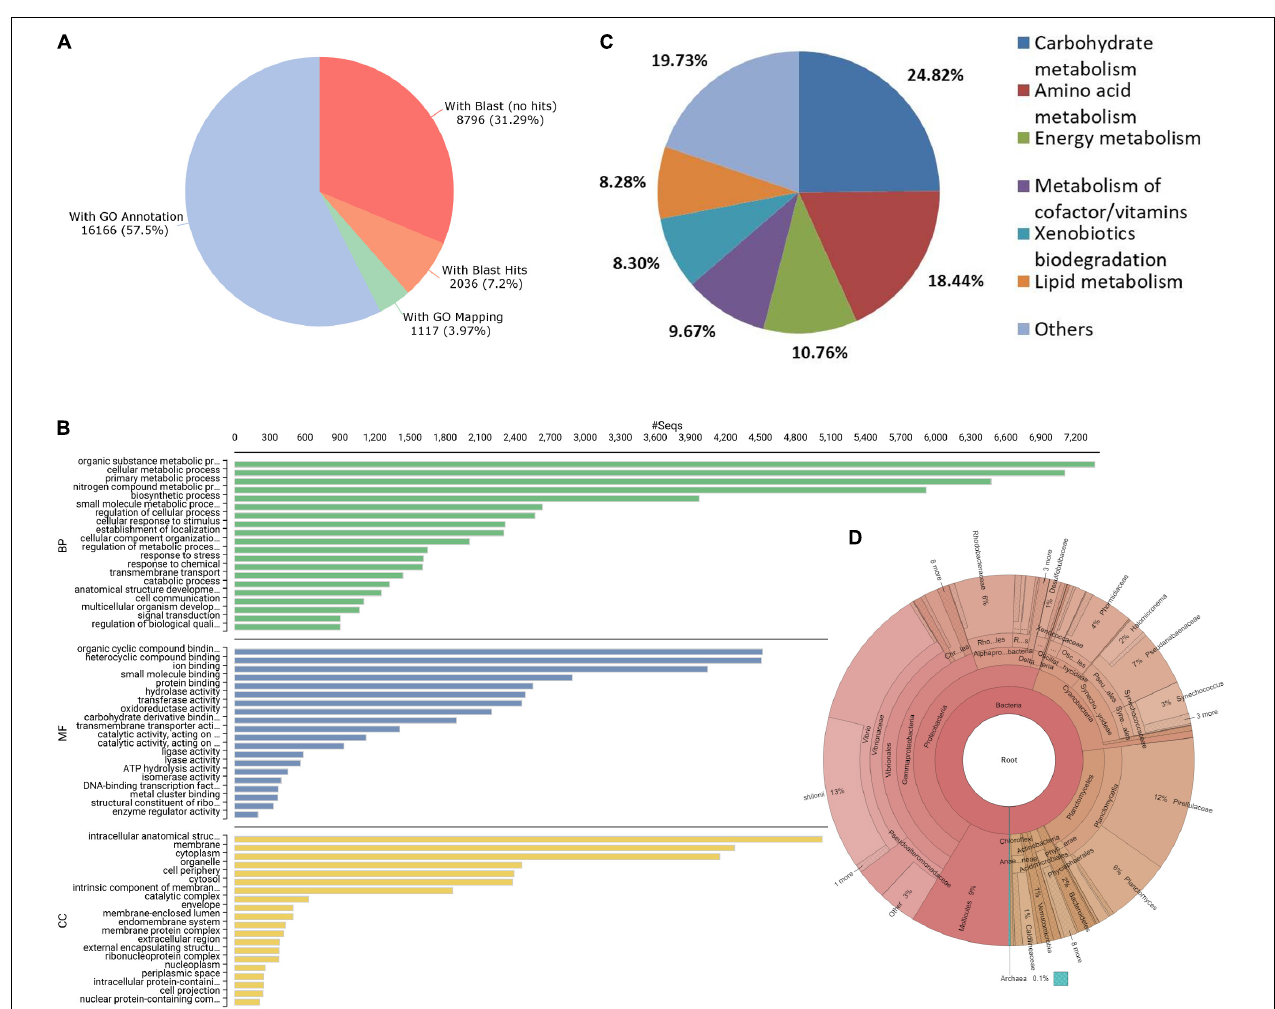
FIGURE 1 | (A) Annotation summary of unigenes. (B) Distribution of most abundant Gene ontology (GO) terms. (C) Represented Kyoto Encyclopedia of Genes and Genomes (KEGG) pathways of unigenes. (D) Representation of intestinal microbial composition through Krona